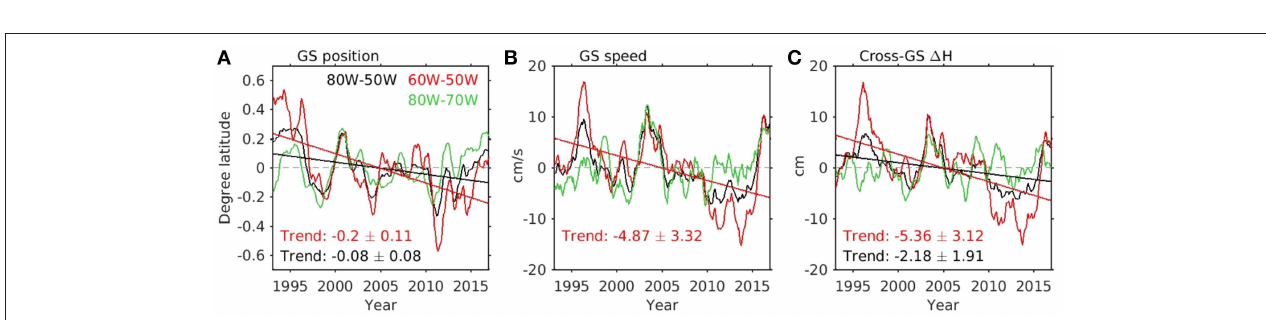
FIGURE 4 | Zonally averaged Gulf Stream (A) position, (B) speed, and (C) cross-front sea surface height (SSH) difference (proxy for transport) derived from satellite altimetry.